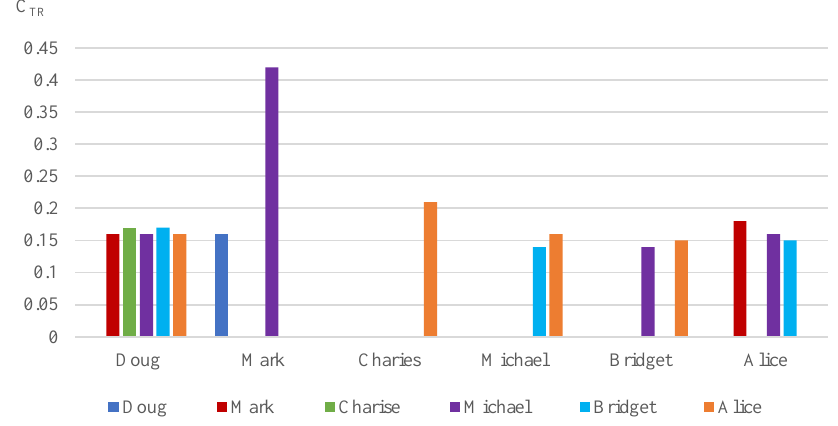
Figure 4. Users’ electricity transmission cost C TR